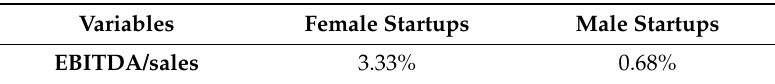
Table 6. Profitability.